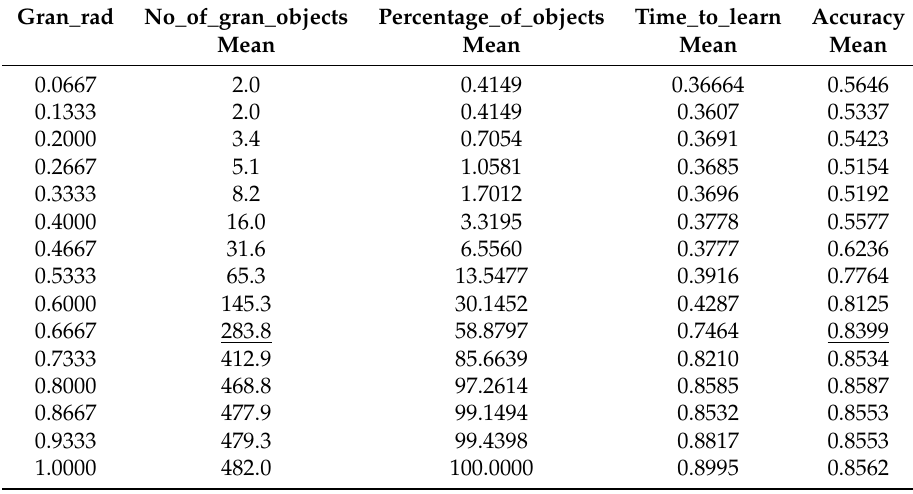
Table 25. Results for Australian Credit dataset (mean from 10 experiments). Classification based on learning of deep neural networks–see